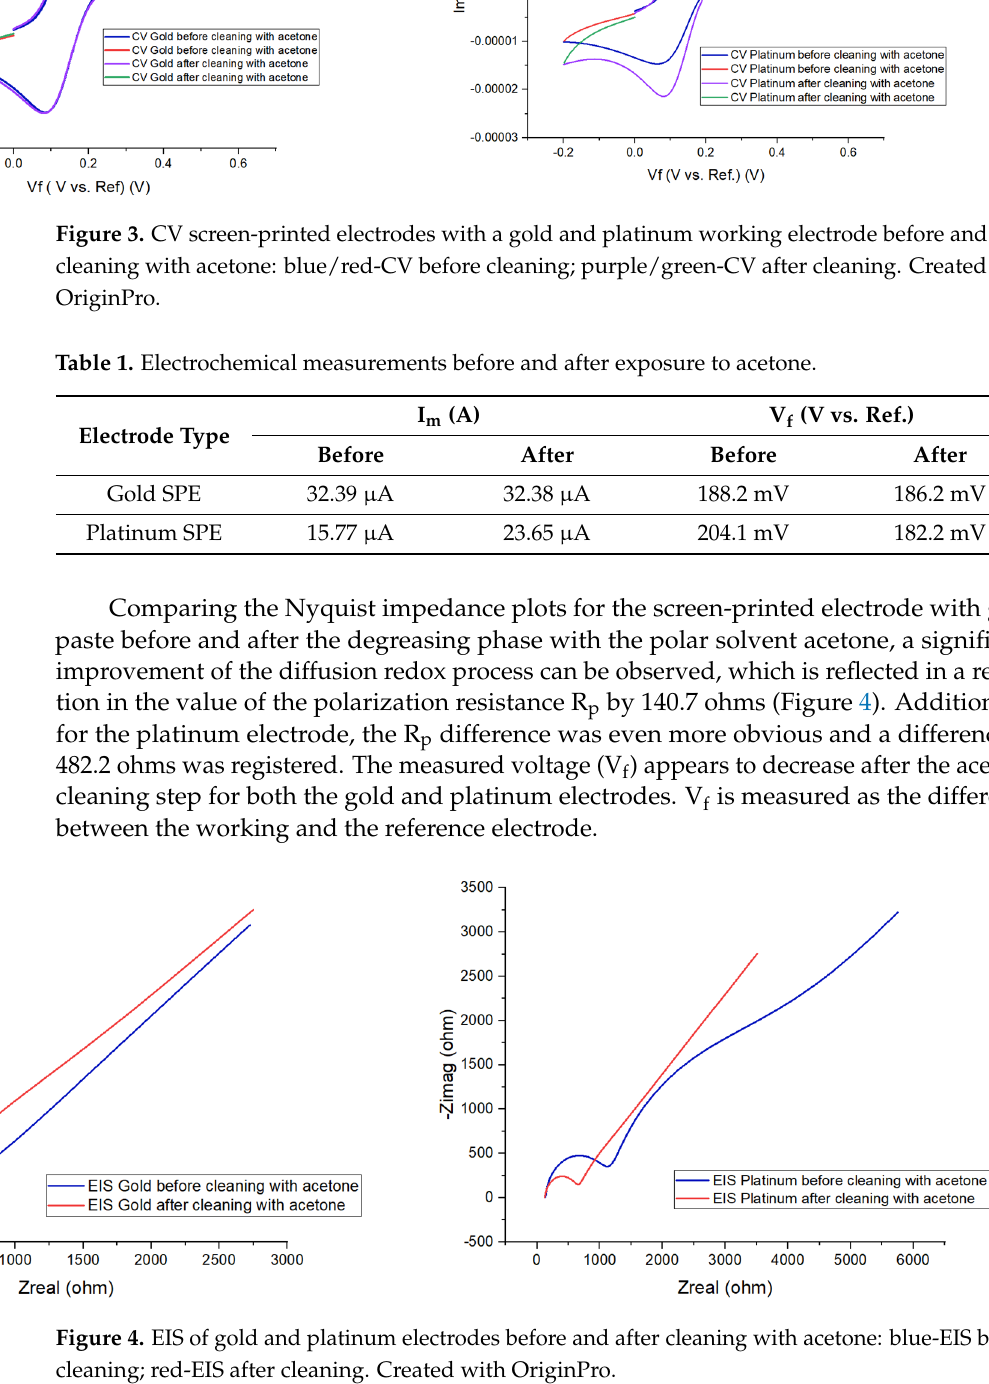
Table 2. EIS measurements for polarization resistance R p , gradient, intercept (sum between the charge of the double layer Q dl and the charge of the species of the solution Q i ) and correlation coef- ficient r, before and after degreasing with acetone, frequency range 0.1 mHz ÷ 100 kHz in a 5 mM solution of K 4 [Fe(CN) 6 ]/K 3 [Fe(CN) 6 ] . Electrode Type R p ( ohm )